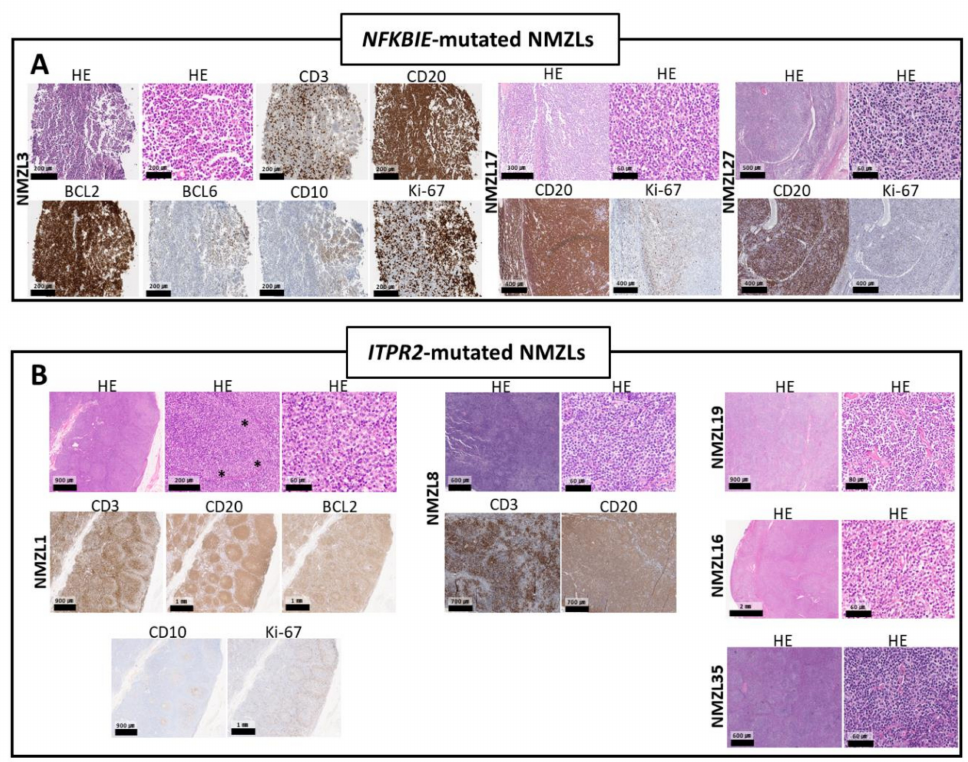
Figure 3. Histologic features of NMZLs harboring NFKBIE or ITPR2 mutations. (A) NMZLs with NFKBIE mutations had varying proportions of medium-to-large B-lymphocytes intermingled with small cells. Heterogeneous medium-sized, CD20-positive, plasmacytoid B-cell proliferation, intermingled with small lymphocytes and a few large cells, was observed in a neck lymph node (LN) of NMZL3 (left), which also exhibited high Ki-67 positivity. The LNs of NMZL17 (middle) and NMZL27 (right) were composed of occasional large blastic cells intermingled with small lymphocytes. (B) All cases with ITPR2 mutations showed varying degrees of marginal zone di ff erentiation with proliferation of monocytoid B-cells, sometimes with clear cytoplasm. NMZL1 (left) exhibited prominent marginal zone hyperplasia (asterisk) (abbreviations: hematoxylin and eosin